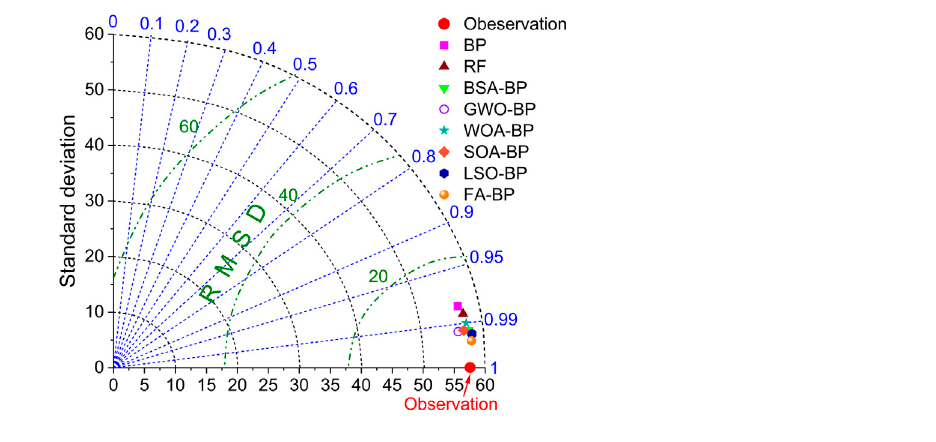
FIGURE 9 | Taylor diagrams for all prediction